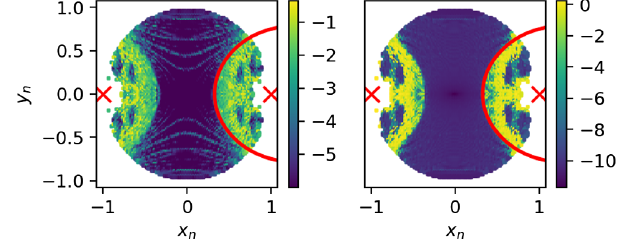
FIG. 20. Dynamic aperture by FMA (left) and REM (right) on toy-model using measured tune error over the arc of individual particles. The time interval is T ¼ 256 .